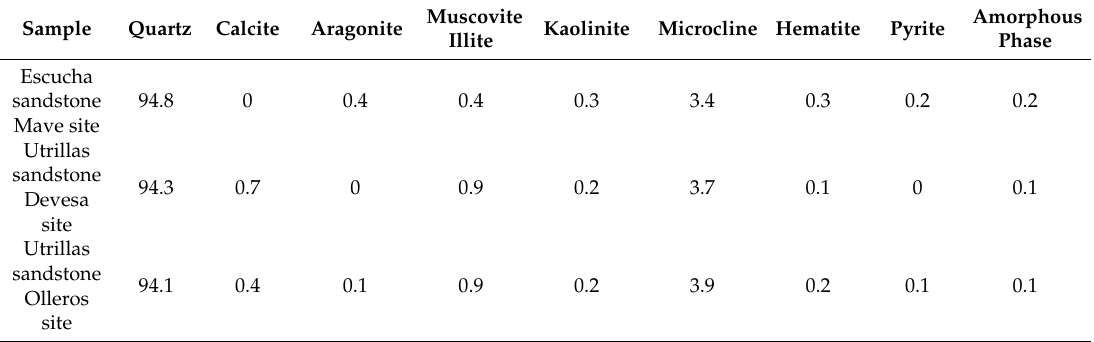
Table 3. XRD mineralogical composition. Mean values were calculated on the basis of 5 samples for each sandstone type.